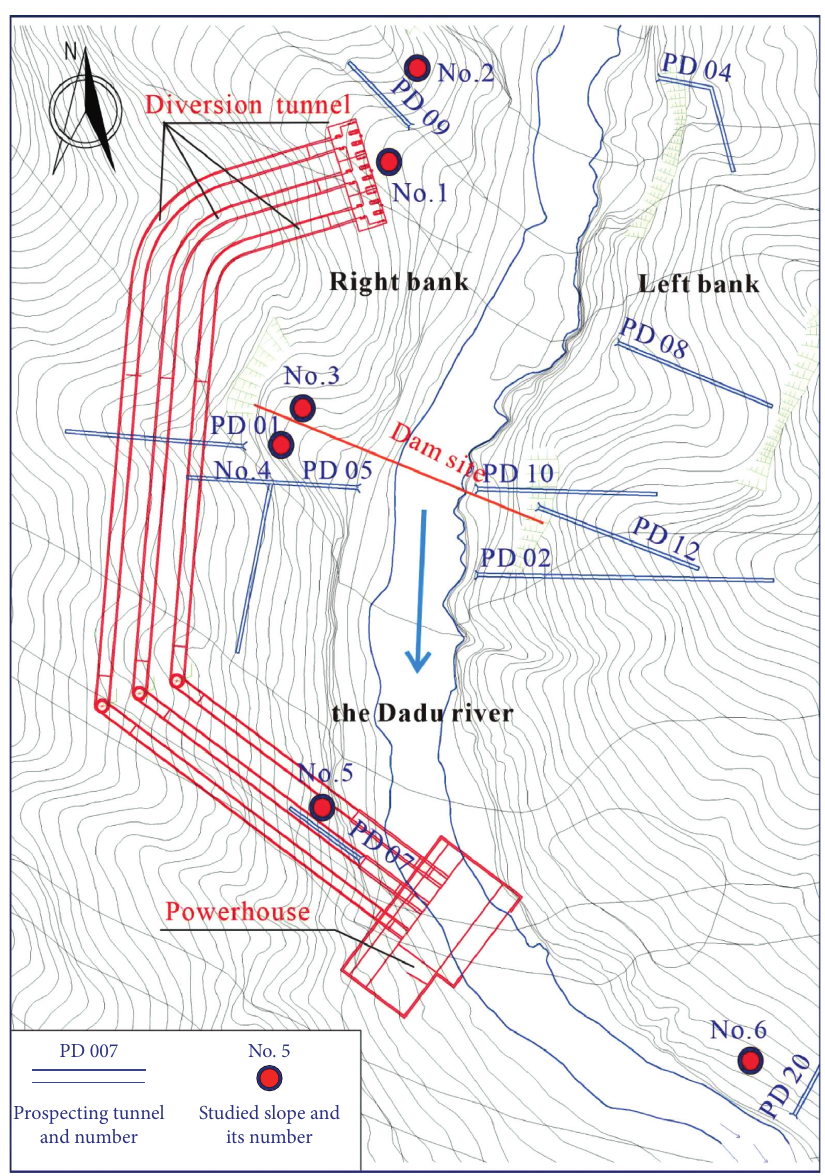
Figure 2: Distribution of the prospecting tunnels in the dam